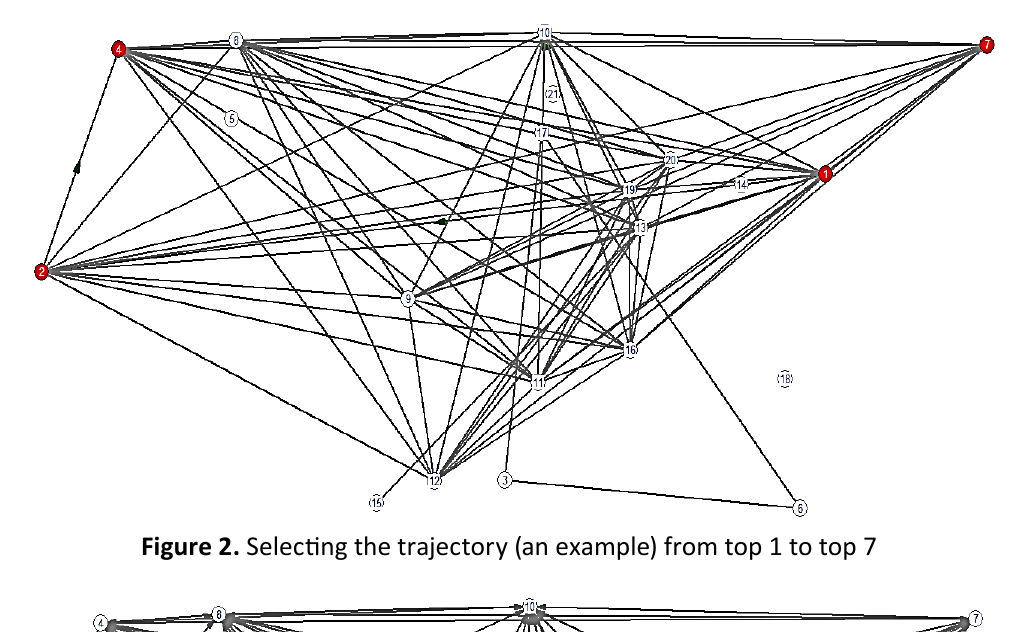
Figure 1. General view of the undirected link graph for banks with direct links